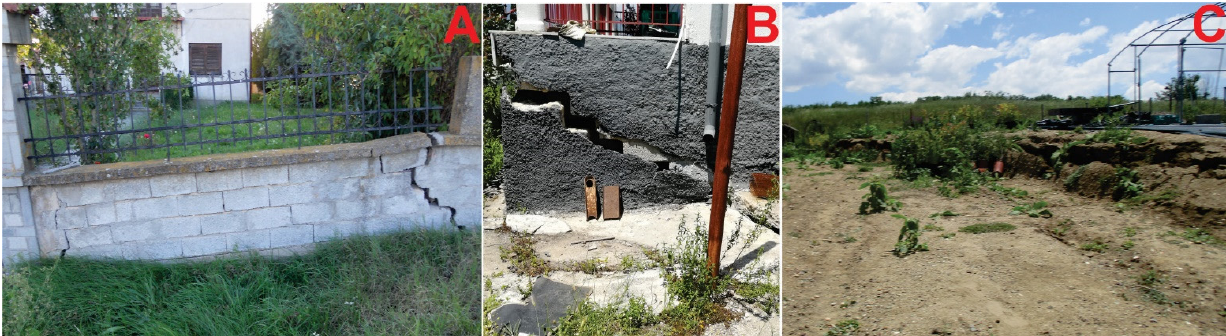
Figure 12. ( A ) Wall fence damaged due to vertical displacements of up to 30 cm at Valtonera village. ( B ) Damaged building wall and ( C ) greenhouse at Anargiroi village.